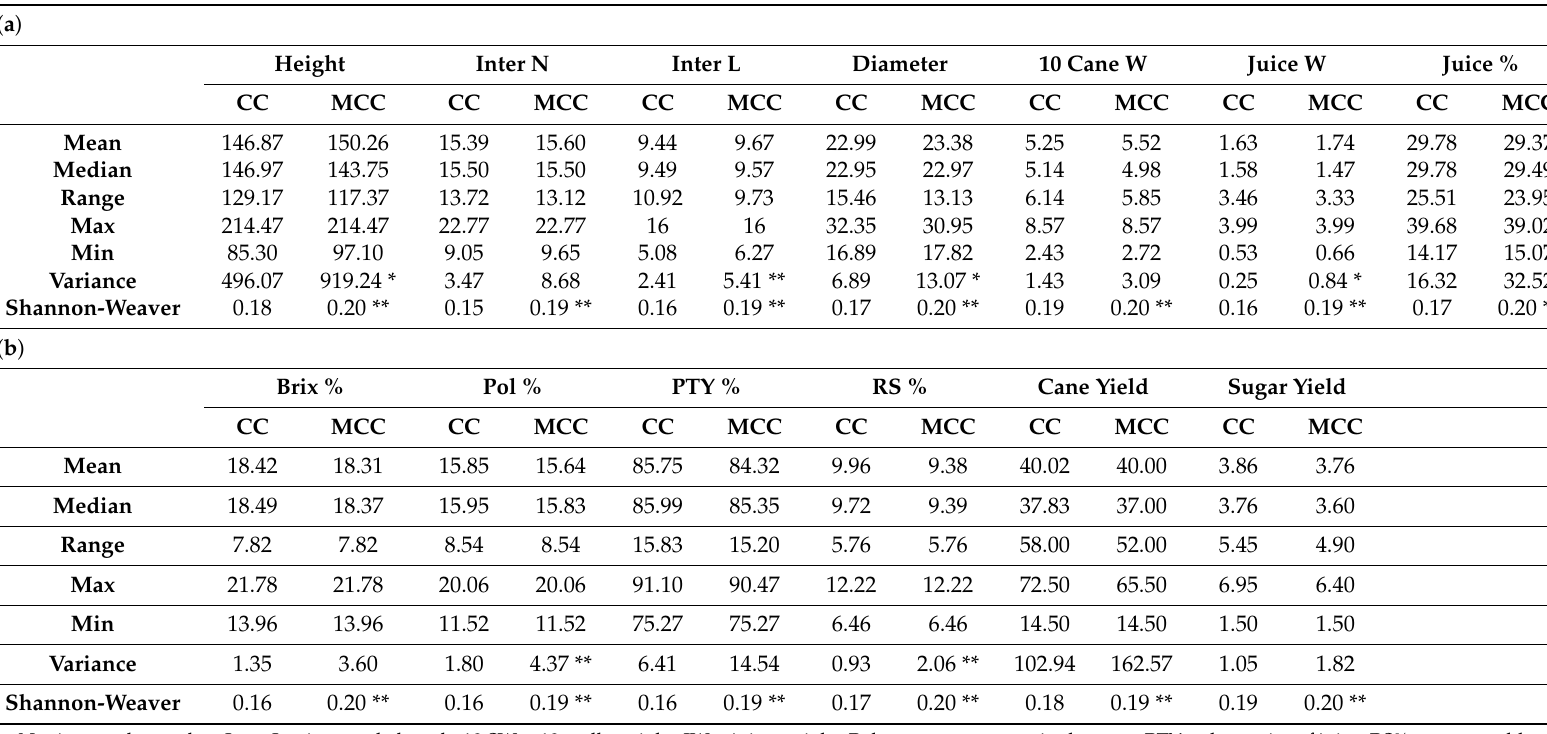
Table 7. Comparison of descriptive statistics of the accessions growing in the primary germplasm of the sugarcane collection (means of two season), and the accessions from this collection selected for the mini-core collection (breeding collection), table (b) is continue of table (a).